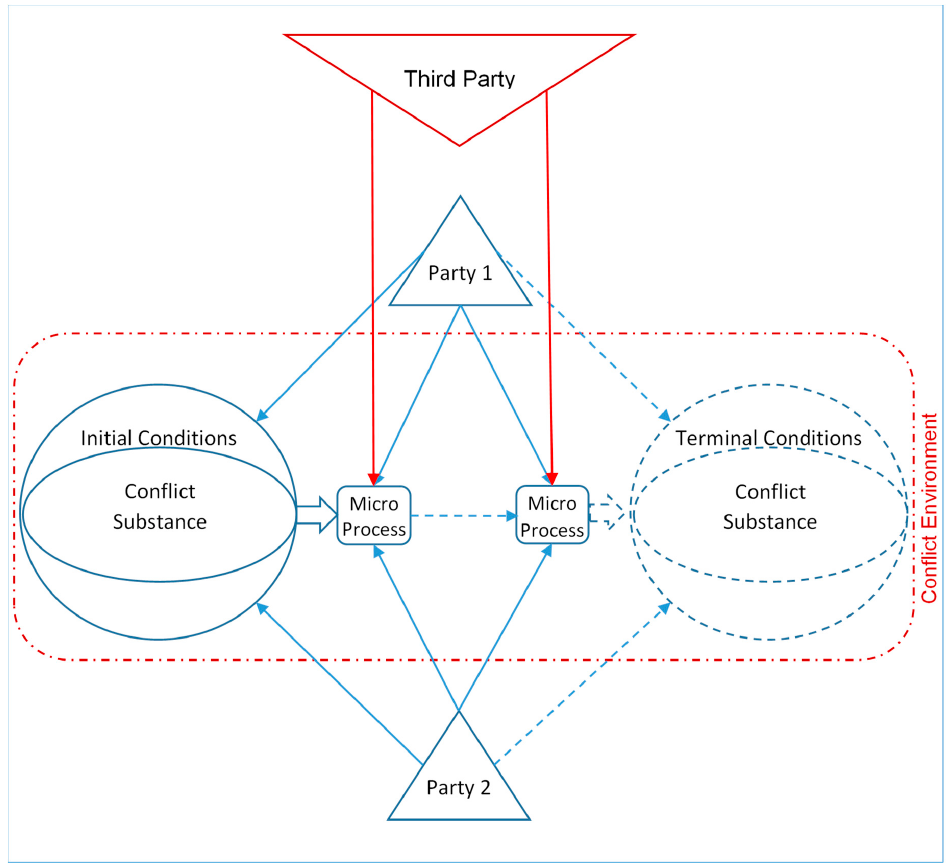
Figure 11. Structure of Alternative Dispute Resolution (ADR) Mechanism.